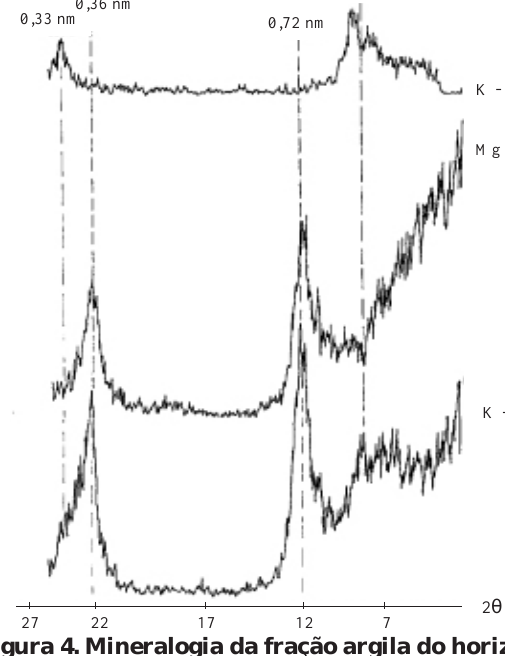
Figura 3. Mineralogia da fração argila do horizonte A do Solo Litólico. M = Mica; Ka = Caulinita. p